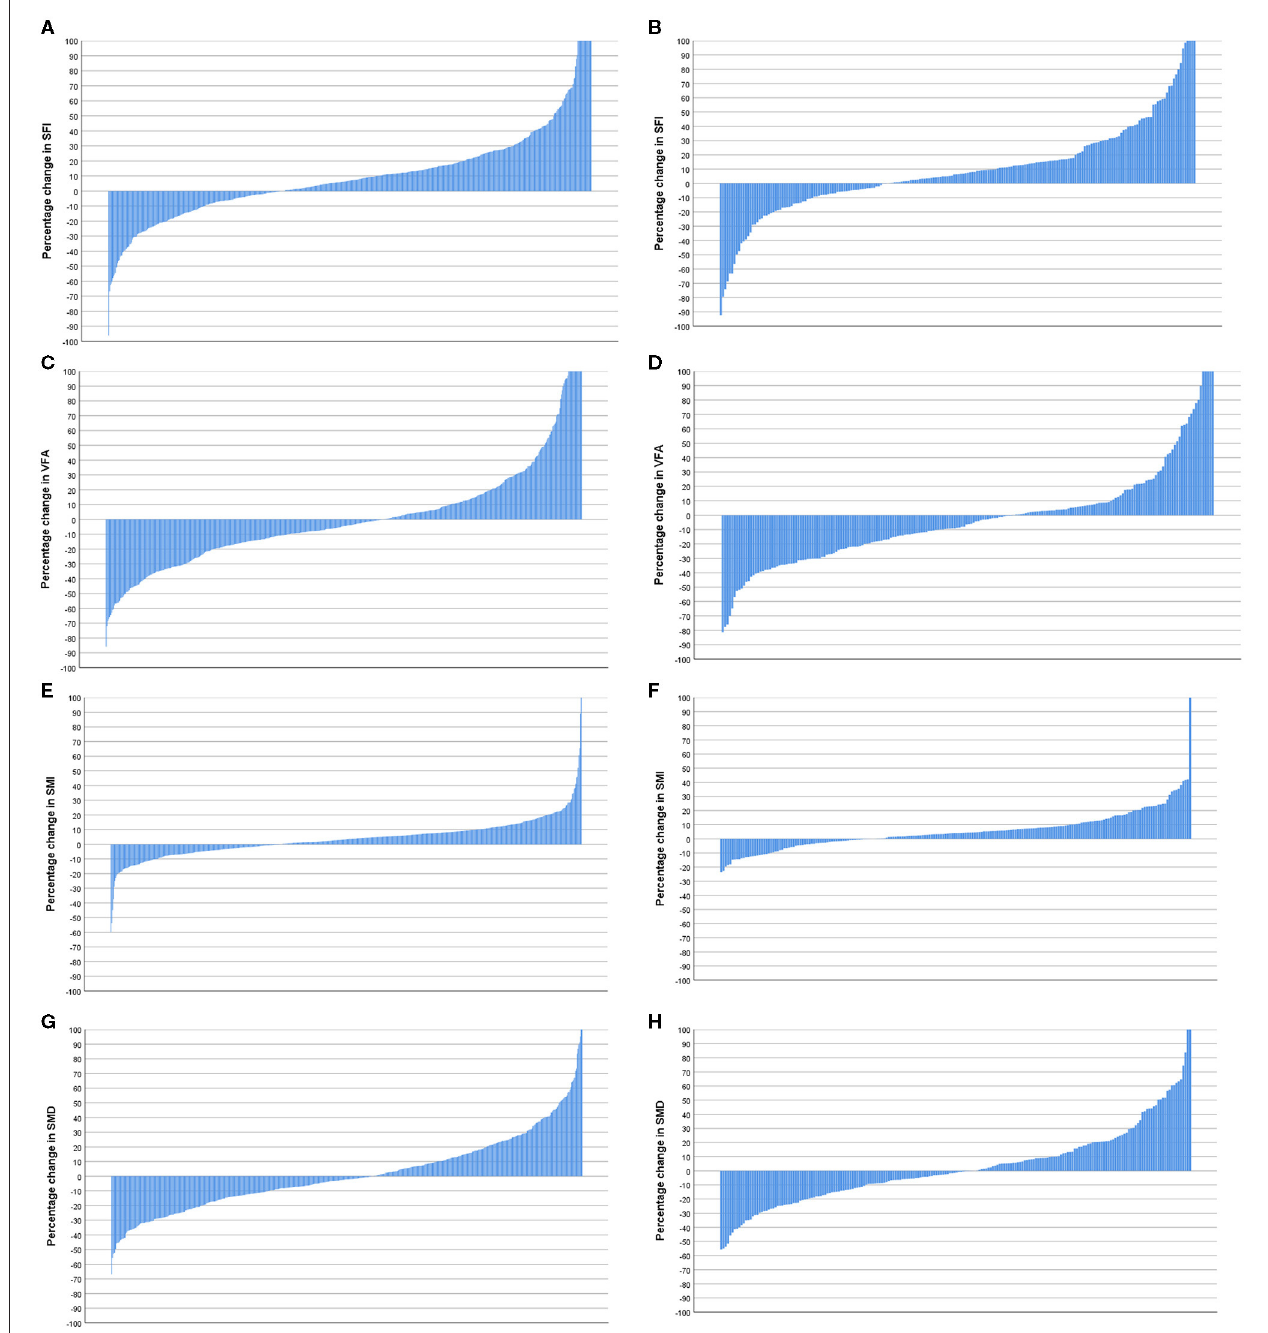
FIGURE 5 | (A) Percentage change in subcutaneous fat index (SFI) in patients < 74 years of age ( n = 596). (B) Percentage change in SFI in patients > 74 years of age ( n = 208). Comparison of percentage change in SFI in patients < 74 years ( n = 596) and > 74 years of age ( n = 208) ( p = 0.922). (C) Percentage change in visceral fat area (VFA) in patients < 74 years of age ( n = 596). (D) Percentage change in VFA in patients > 74 years of age ( n = 208). Comparison of percentage change in VFA in patients < 74 years ( n = 596) and > 74 years of age ( n = 208) ( p = 0.171). (E) Percentage change in skeletal muscle index (SMI) in patients < 74 years of age ( n = 596). (F) Percentage change in SMI in patients > 74 years of age ( n = 208). Comparison of percentage change in SMI in patients < 74 ( n = 596) and > 74 years of age ( n = 208) ( p = 0.197). (G) Percentage change in skeletal muscle density (SMD) in patients < 74 years of age ( n = 596). (H) Percentage change in SMD in patients > 74 years of age ( n = 208). Comparison of percentage change in SMI in patients < 74 years ( n = 596) and > 74 years of age ( n = 208) ( p = 0.721).